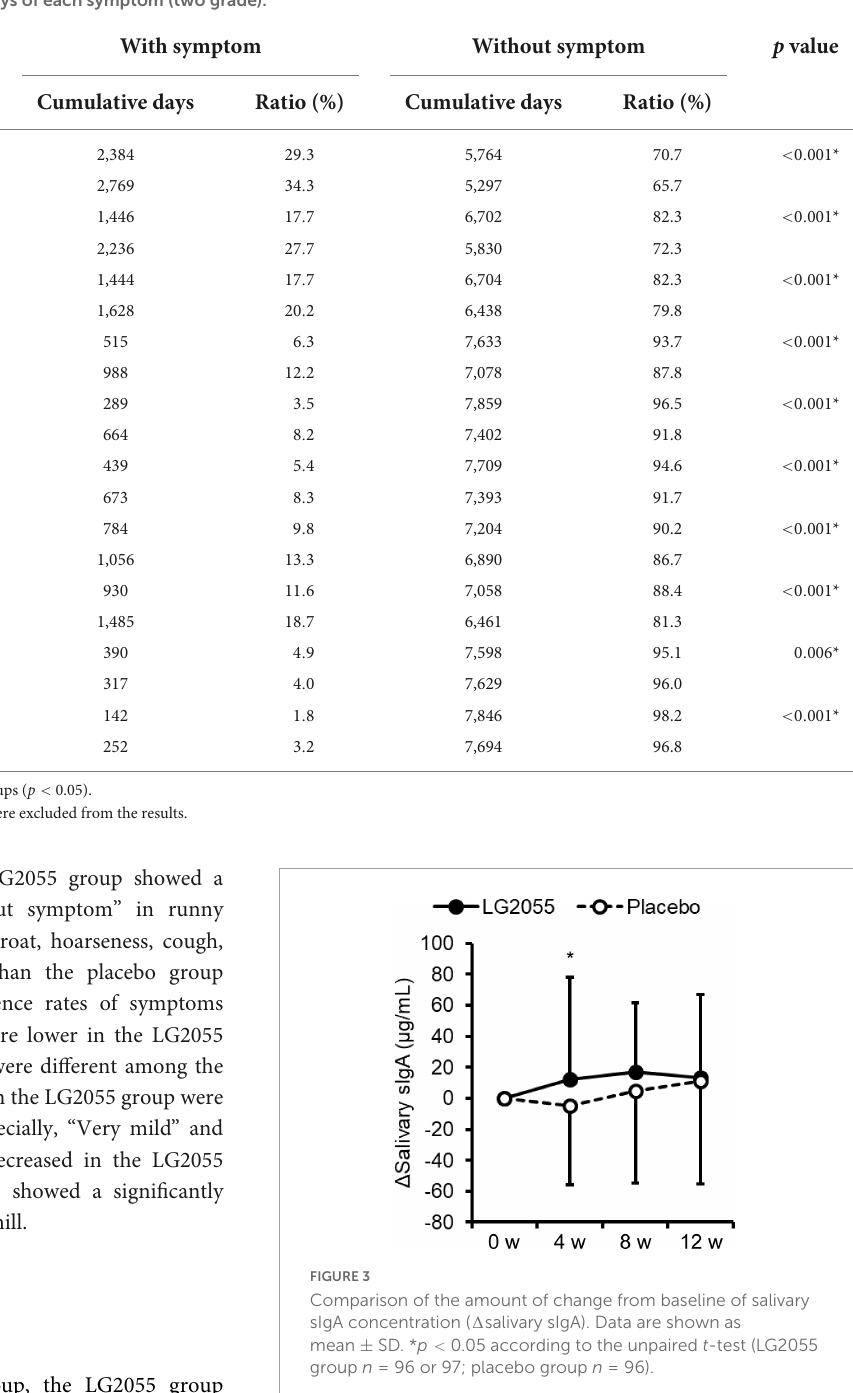
TABLE 3 Comparison of the cumulative days of each symptom (two grade).